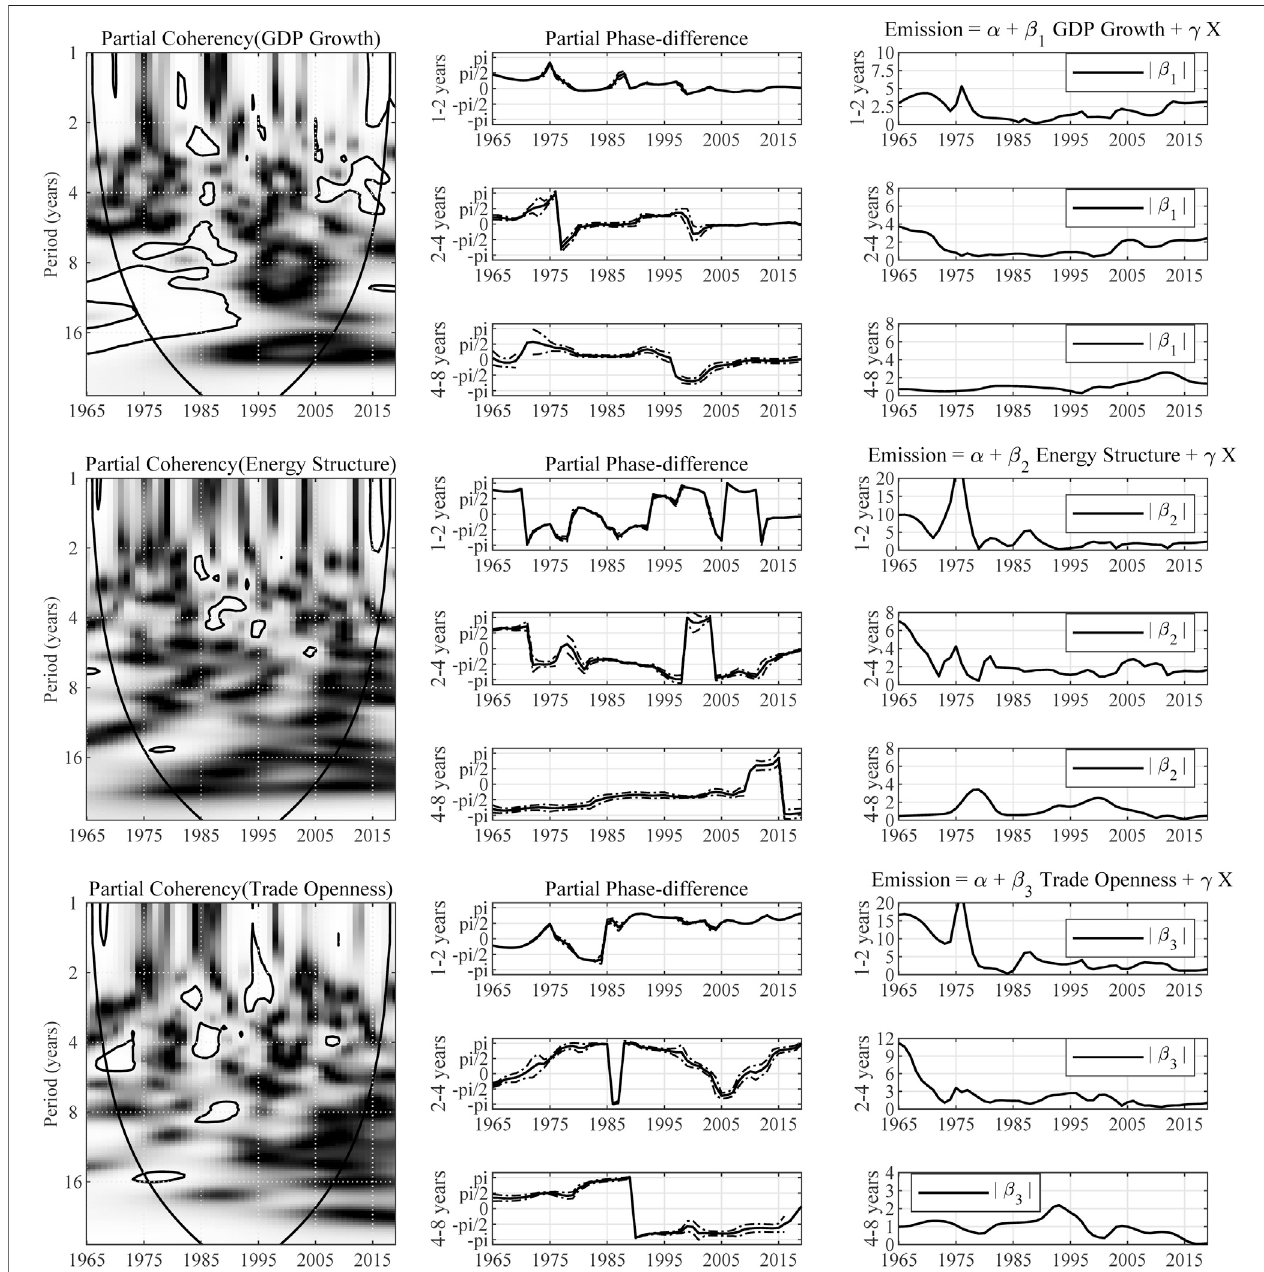
FIGURE 7 | Multivariate wavelet analysis results for Brazil. Note: The expression “ Partial Coherency (Z) ” denotes the partial coherency between variable Z and carbon emission,controlledforthein fl uencefromotherfactors.Theareas belowthesymmetricblackconvexcurvethatappearsinthe fi gureofcoherencyarecalledthe “ Cone of In fl uence (COI), ” in which the edge effects are profound. Inside the COI, the results tend to be unreliable. The contours in the coherency diagrams indicate 5% signi fi cance level, bootstrapped for 10,000 replications. And, the brighter colors correspond to higher signi fi cance level, and darker colors correspond to lower signi fi cance level. The dotted lines accompanying the partial phase-difference indicate the 95% con fi dence